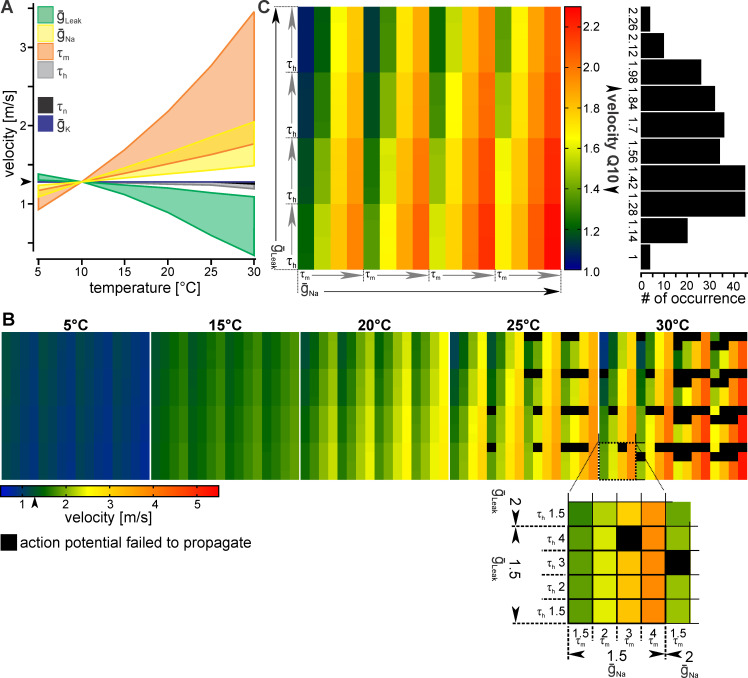
Similar velocity changes in response to temperature can be achieved though ion channel properties with widely different temperature-sensitivities.(A) Model prediction of how the temperature sensitivity of each channel property (Q10 = 1.5, 2, 3, or 4) influences propagation velocity. Colored area shows the velocity range resulting at each temperature. The arrowhead identifies the propagation velocity of the axon at baseline temperature (10°C). (B) Influence of different channel property Q10s on propagation velocity. A single axon is shown at different temperatures. Each colored square represents an axon with a unique combination of ion channel property Q10s. Colors give the measured AP conduction velocity. Sodium channel activation gate time constant and maximum conductance Q10s increase horizontally, while maximum leak conductance and Sodium channel inactivation gate Q10s increase vertically (bottom inset). (C) Left: Temperature-dependence of AP propagation velocity, measured as velocity Q10s for each unique model. Q10s were calculated from their velocities at 5 and 15°C. Right: Quantification of total Q10 occurrence.